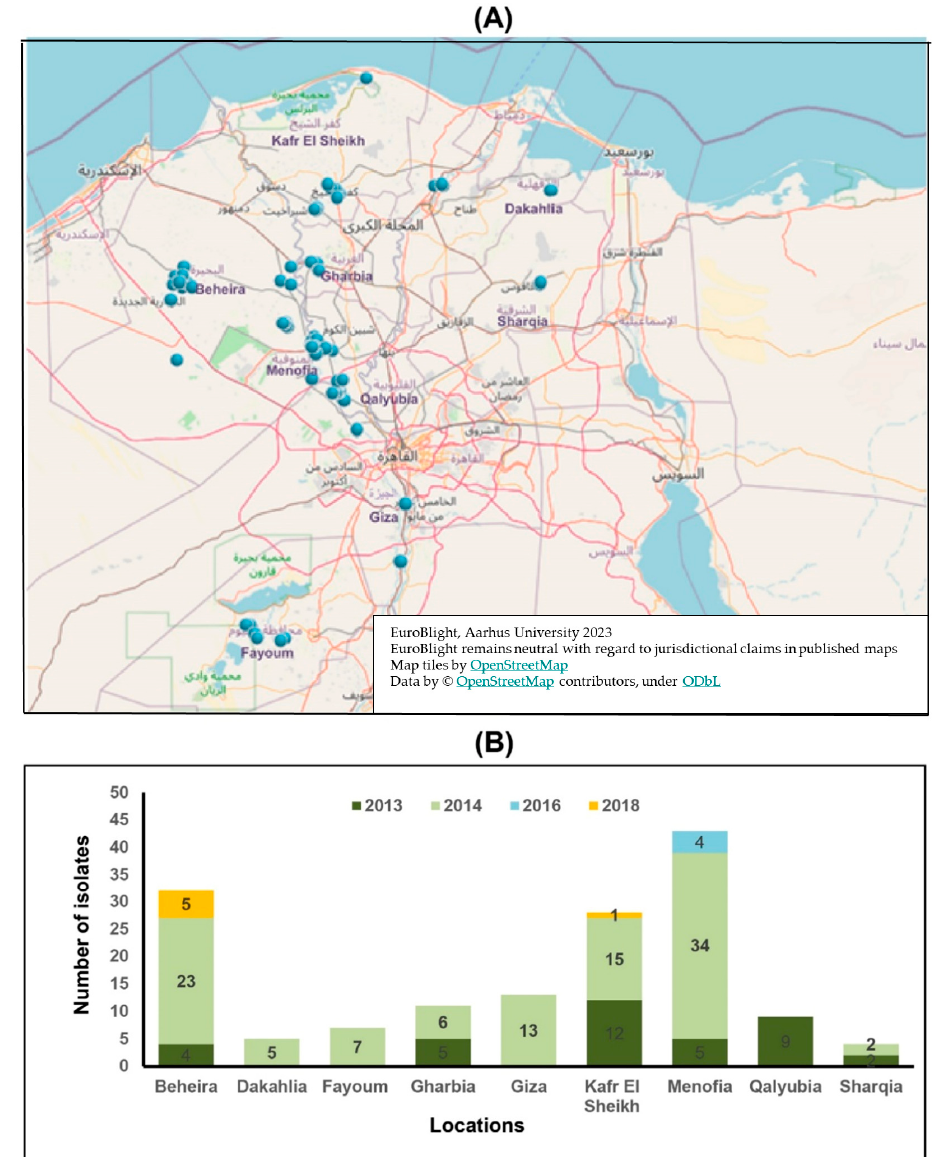
Figure 1. Late blight monitoring map showing locations of nine Egyptian governorates ( A ), Number of obtained isolates from nine different Egyptian governorates during four growing seasons ( B ). The map was drawn using online Euroblight database (https://agro.au.dk/forskning/internationale- platforme/euroblight/pathogen-monitoring/genotype-map, accessed on 21 January 2023).